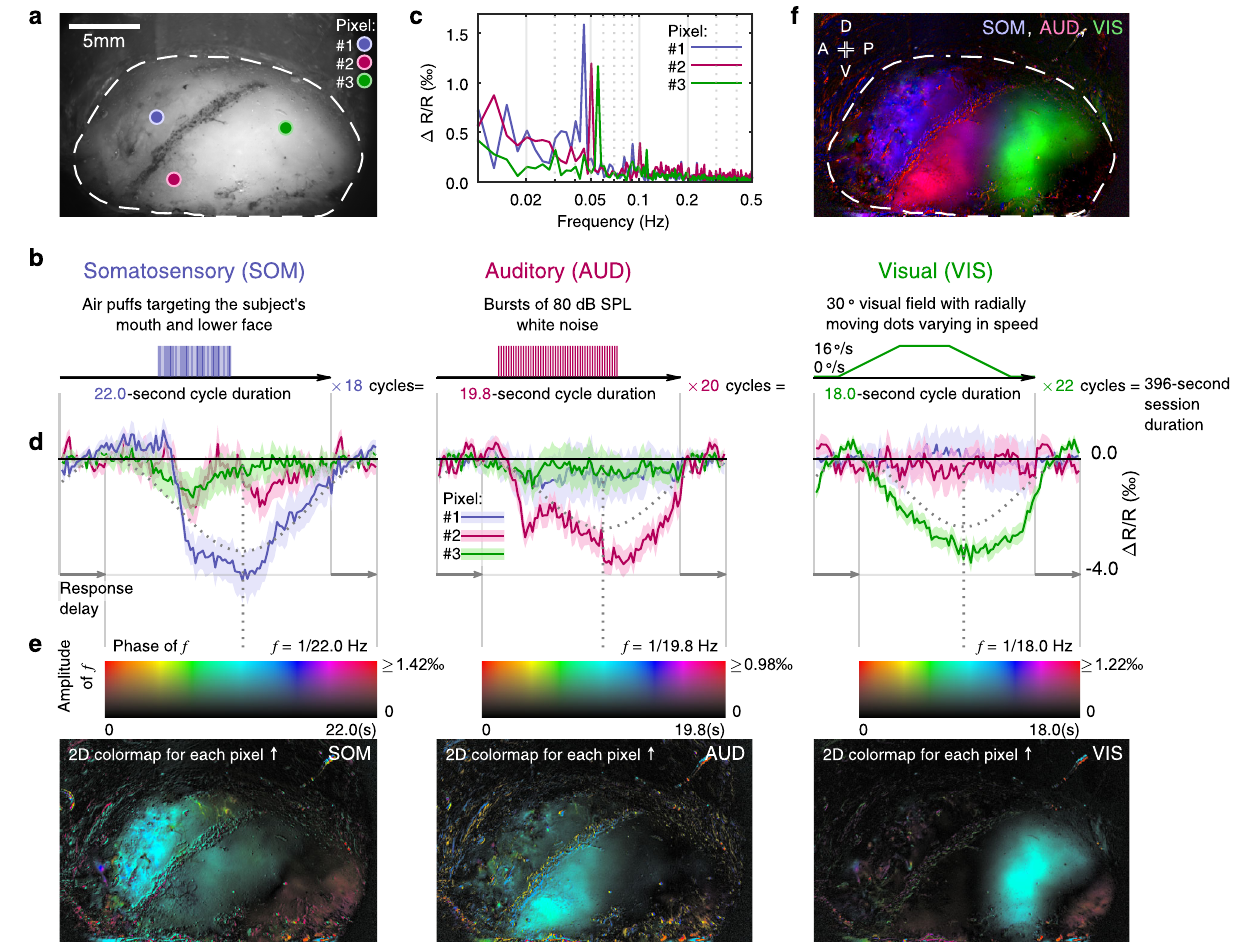
Fig. 2 Through-skull parcellation of functional modalities in marmoset cortex. a A view of the recording chamber (subject M126D) with the locations of three exemplar pixels labeled. Dashed contour: the extent of the imageable area over the skull surface. b Stimulus design for functionally parcellating somatosensory (SOM), auditory (AUD), and visual (VIS) cortices. c The spectra of the exemplar pixels calculated across the entire recording session, following the same color scheme in ( a ). d Intrinsic signal responses from the three exemplar pixels labeled in ( a ) to the stimuli shown in ( b ), following the same color scheme in ( a ). Each average response trace is shown as a solid line with a shade representing the standard error mean (SEM, n = 18 cycles for SOM; n = 20 cycles for AUD; and n = 22 cycles for VIS, in the relative change of re-emitted light, or Δ R / R ). For each modality, a cosine fi tting curve to the trace of the most responsive exemplar pixel is drawn (dotted cosine line) with the response phase indicated by a dotted vertical line. e Response maps of the three modalities (left: SOM, middle: AUD, right: VIS). For each pixel, the cosine fi tting phase (delay-compensated) and amplitude are encoded respectively as color and intensity in the map, according to the 2D colormap shown above each modality map (for response maps from all tested subjects, see Supplementary Fig. 4). f A summary map based on the modality parcellation results in ( e ), with each modality represented in a color channel (red: auditory, green: visual, blue: somatosensory). A: anterior; P: posterior; D: dorsal; V: ventral. Dashed contour: the same as in ( a